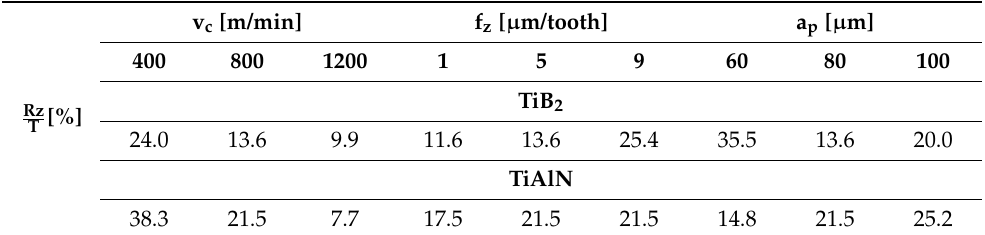
Table 1. Ratio of surface roughness parameter Rz to dimensional tolerance range